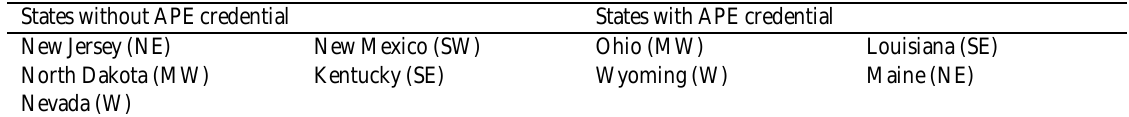
Table 2. States randomly selected by region and credential